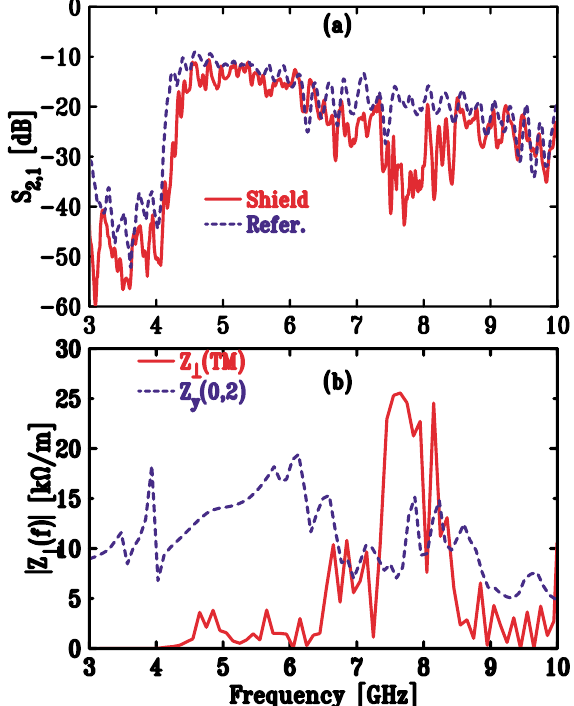
FIG. 14. (Color) (a) Measured S of the bellows shield and the reference section versus frequency and (b) the estimated transverse beam impedance of the shield compared with the impedance calculated by GDFIDL , Z